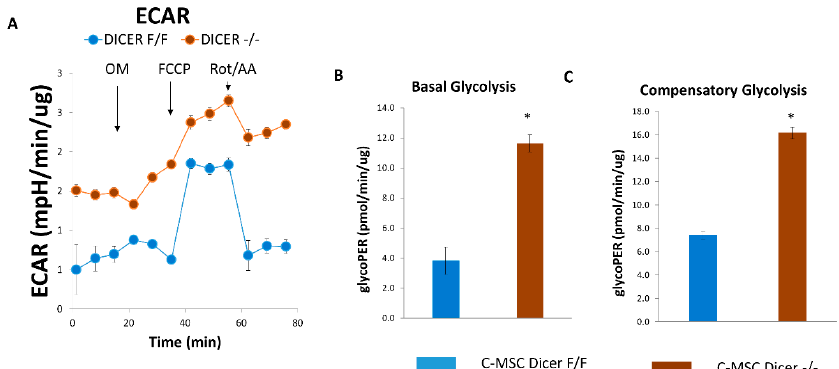
Figure 4. Assessment of extracellular acidification rate (ECAR) in Dicer F / F and Dicer − / − C-MSC. ( A ) Normalized ECAR data. ( B , C ) Measurements of basal glycolysis and compensatory glycolysis from the ECAR tracing in ( A ). Results are normalized to total cellular protein and shown as mean with SEM ( n = 8), * p < 0.05.